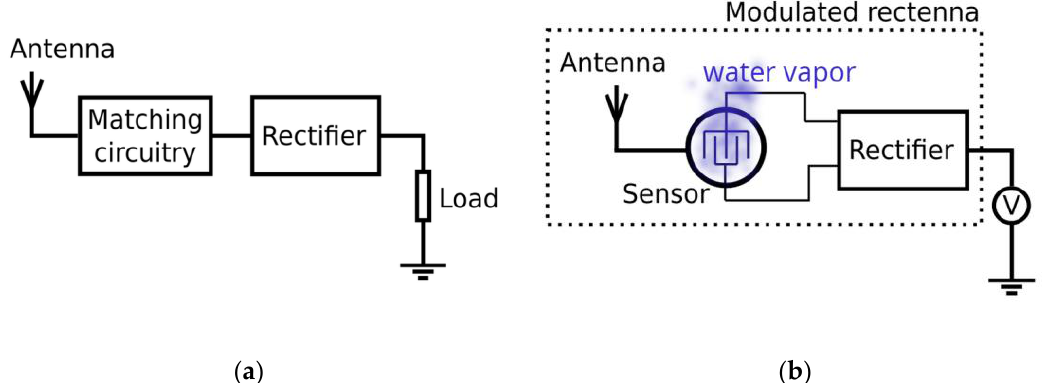
Figure 2. Concept of the sensor operation: ( a ) EM harvesting by rectenna: basic structure; ( b ) The modified rectenna used in this work for humidity and breath detection. The signal that is harvested by the antenna is modulated by humidity using an interdigitated capacitor made out of activated aluminum.